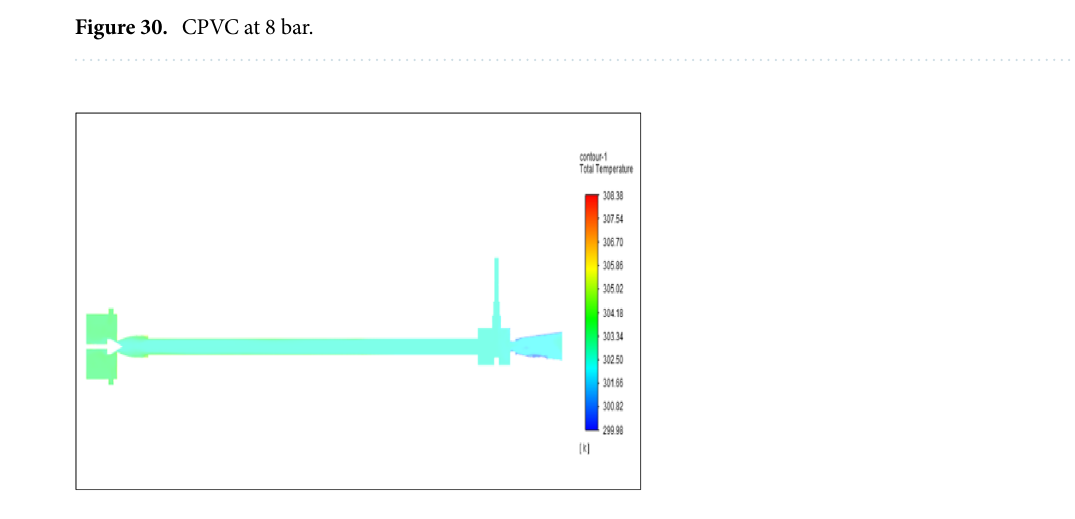
Figure 31. Acrylic at 8